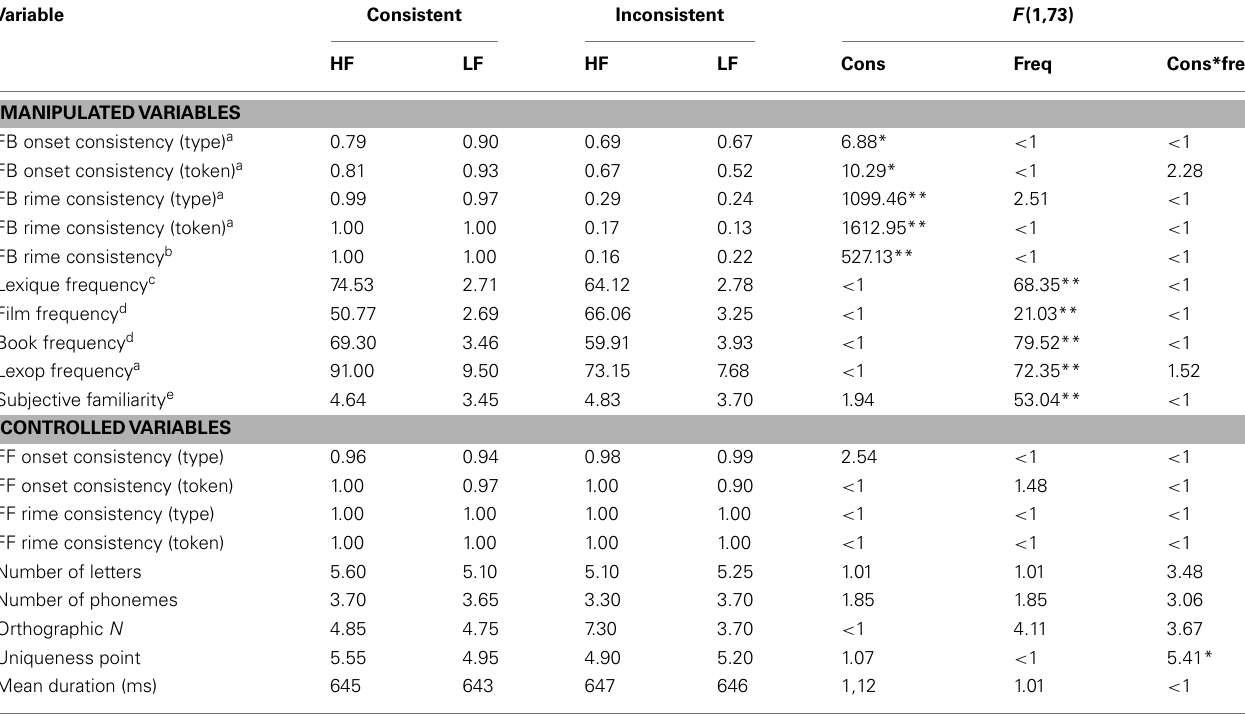
Table 4 | Stimulus characteristics of words used in Experiment 2 (rime detection) manipulating orthographic consistency and word frequency. Variable